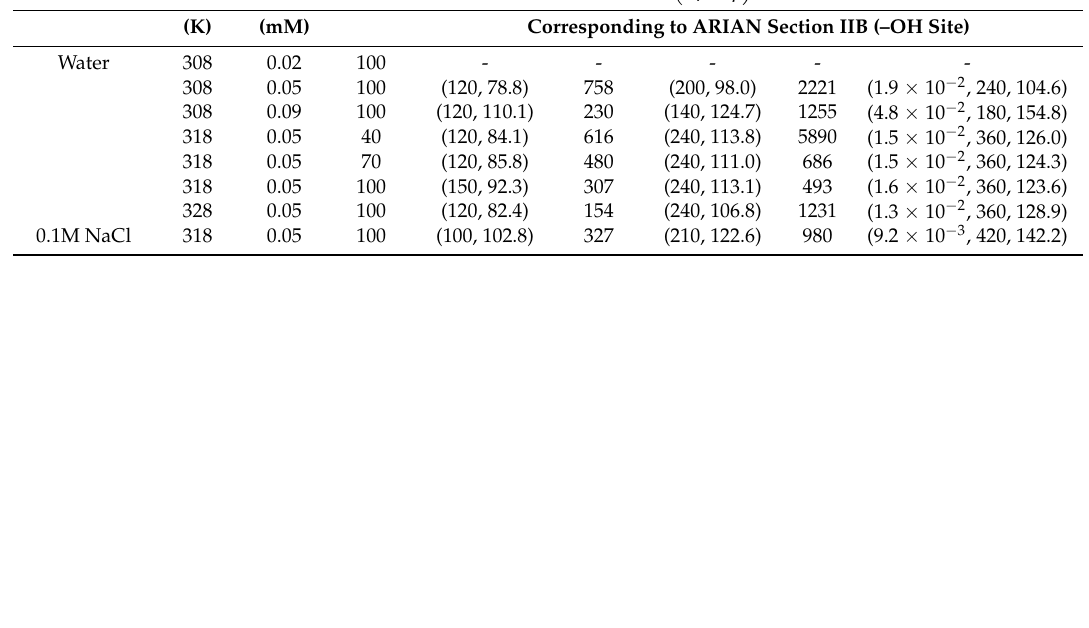
Corresponding to ARIAN Section IIB (–OH Site)